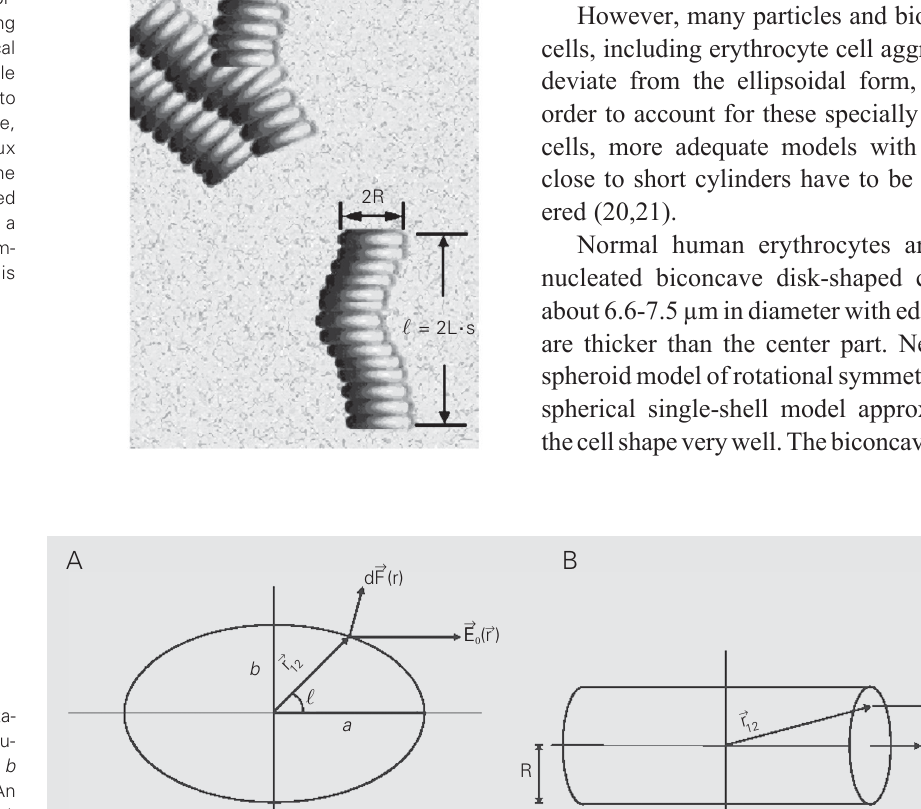
Figure 2. Schematic representa- tion of the electric field distribu- tion for prolate ellipsoids ( a > b →→→→→ = c ) in field direction E 0 (A). An oblate ellipsoid corresponds to b > a = c . B , Dielectric cylinders of length 2L and diameter 2R